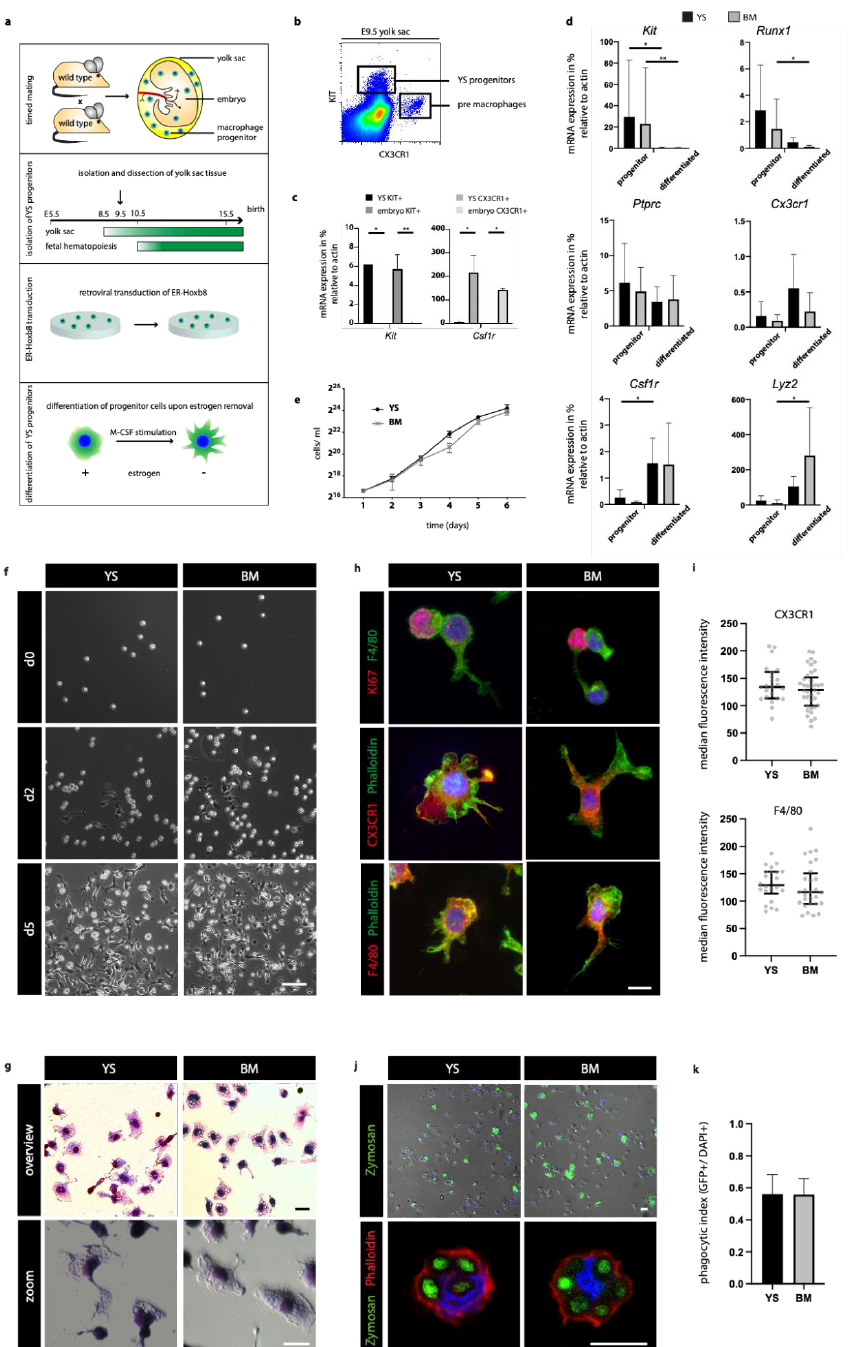
Figure 1. Generation of functional Hoxb8 YS macrophages. ( a ) Schematic graph illustrating the process of Hoxb8 cell line generation. ( b ) Flow cytometry of E9.5 hematopoietic progenitors in the yolk sac (YS) (representative plot, n = 4). ( c ) mRNA